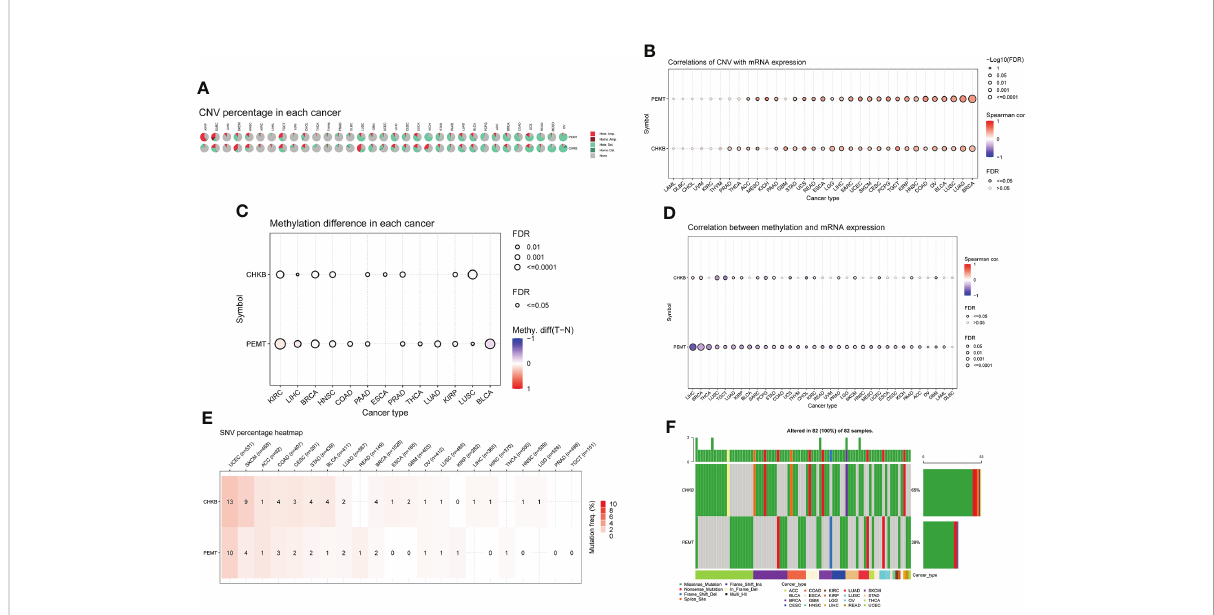
FIGURE 3 Comprehensive analyze the CNV, methylation difference, and SNV of choline metabolism-related genes in pan-cancer. (A) The proportion of CNV in each cancer. (B) Correlation between the expression levels of choline metabolism-related genes and CNV. (C) Methylation differences in each cancer. (D) Correlation of choline metabolism-related genes expression levels with methylation; (E) Heat map of SNV percentage in each cancer. (F) Waterfall plot of mutation types of choline metabolism-related genes in each